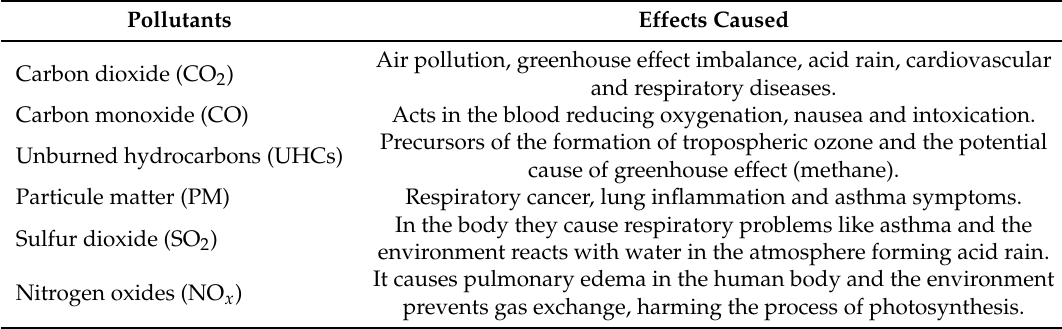
Table 5. Harmful effects on health and the environment caused by the emission of polluting